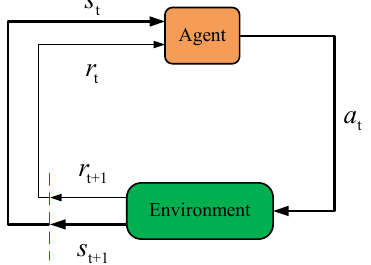
Figure 6. The principle of the reinforcement learning.